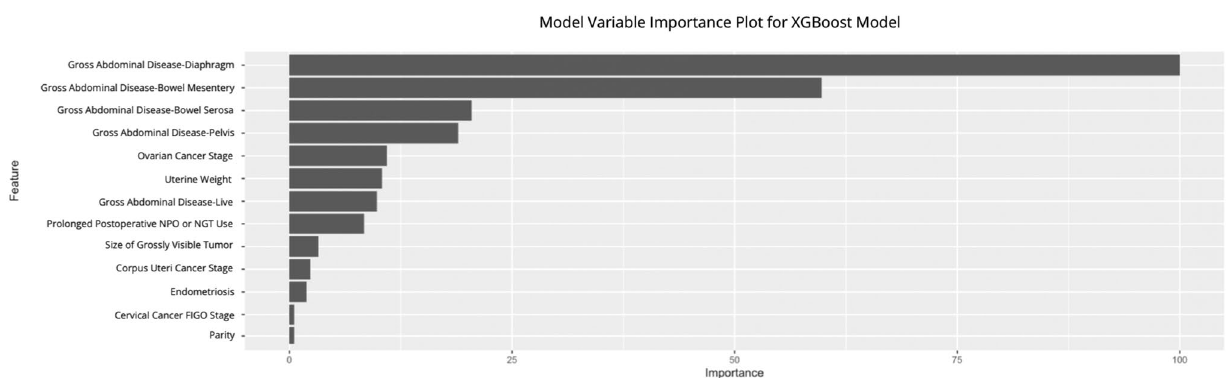
Figure 2. Analysis of the importance of each variable in the XGBoost machine learning model. The histogram describes the relative importance of all 35 clinical features in the logistic regression model. The relative importance is quantified by assigning a weight between 0 and 100 for each variable.